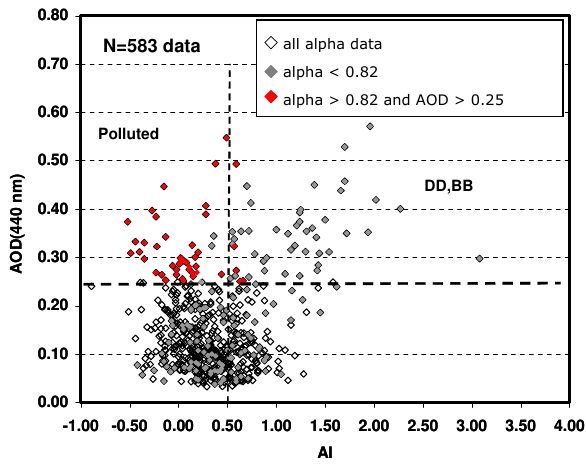
Fig. 4. AOD at 440nm as function of AI index where different subsets of aerosols are indicated. “all alpha data” set includes white, grey and red